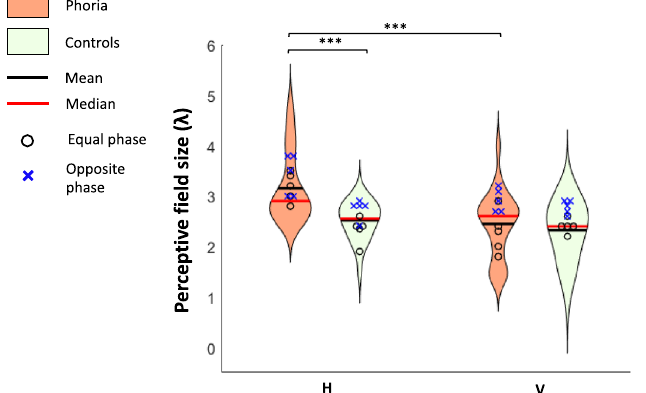
Figure 3. The violin plots represent the distribution of PFs for the horizontal meridian (H) and the vertical meridian (V). Data for the phoric group (n = 5) are denoted in dark orange and for the controls (n = 5) data are denoted in light green. The PF sizes obtained when the target was masked by equal-phase flankers are denoted by a black circle, and the PF sizes obtained when the target was masked by opposite-phase flankers are denoted by a blue cross. ***p ≤ 0.001, **p ≤ 0.01, *p ≤